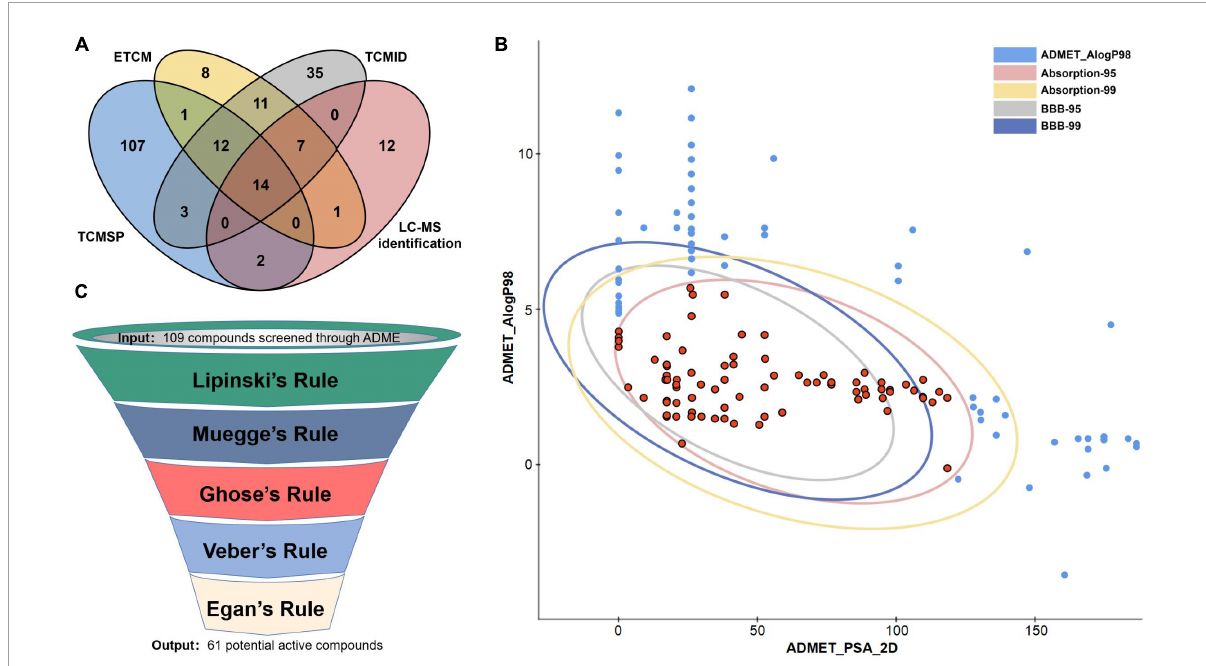
FIGURE2 Screening of potential active compounds in Scutellariae radix . (A) Compounds in Scutellariae radix collected from various databases and LC-MS identification. (B) Bioavailability screening of compounds in Scutellariae radix . (C) Drug-likeness screening of compounds in Scutellariae radix .